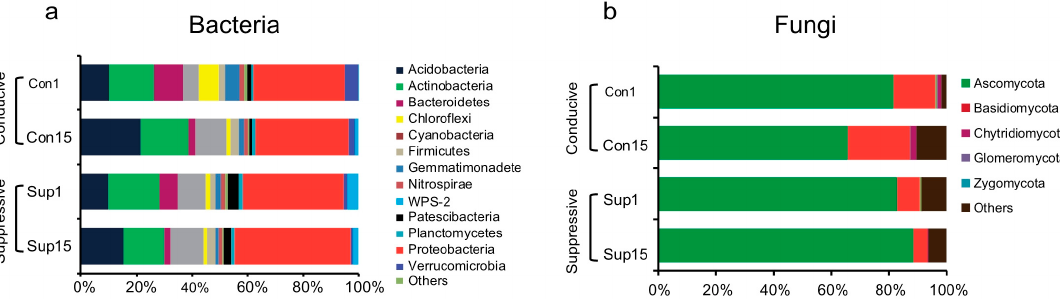
Figure 2. Comparative analyses of rhizosphere microbial communities among the conducive and suppressive soils at the phylum and operational taxonomic unit (OTU) levels. Taxonomic compositions of bacterial ( a ) and fungal ( b ) community under 1- or 15-year monoculture systems at the phylum level.